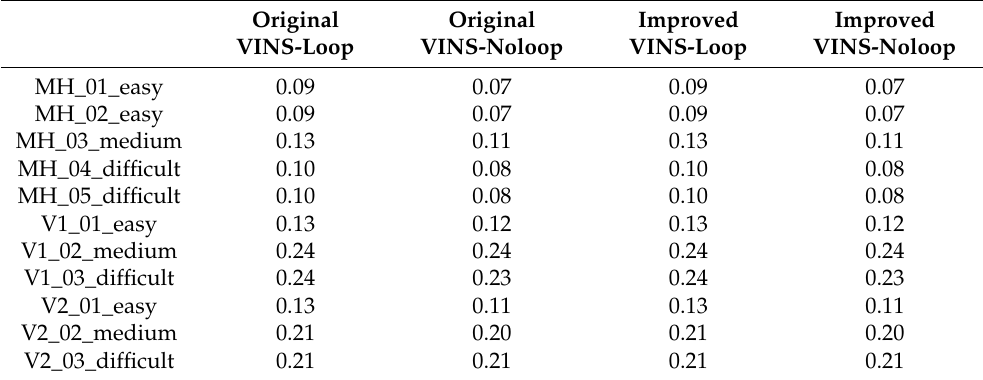
Table 4. The rotation error of the original algorithm is compared with that of the improved algorithm. (Unit-less).